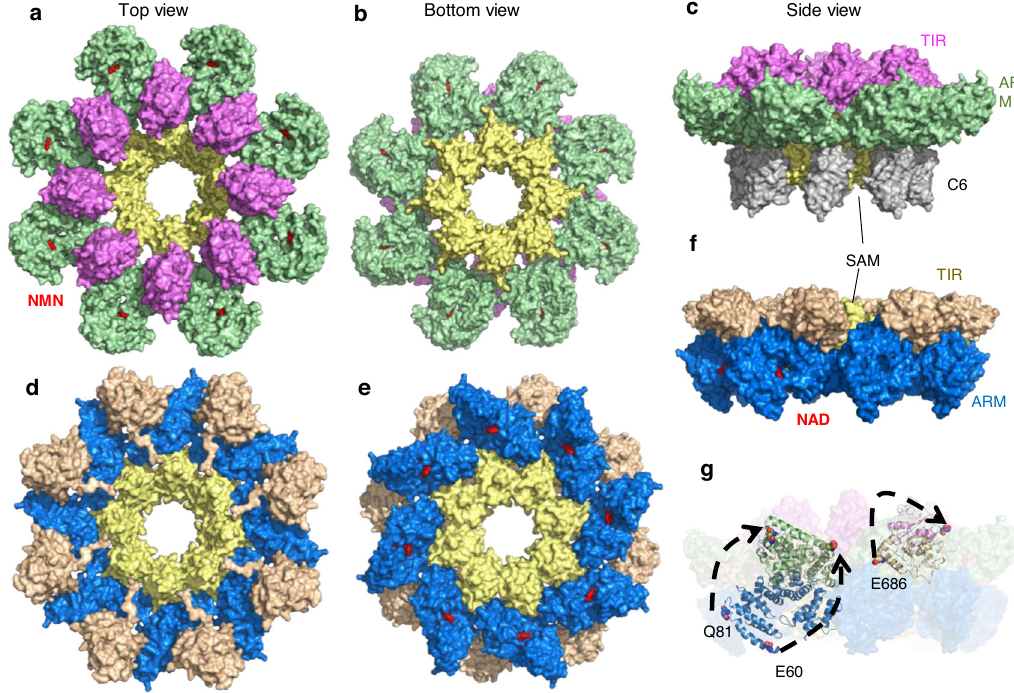
Fig. 3 | Overall structures of active or inactive SARM1. a – c Structure of the SARM1 NMN /Nb-C6complex.TheorderofadditioninformingthecomplexisSARM1 fi rst, NMN second, and then Nb-C6. a top view; b bottom view; c side view. SARM1 and Nb-C6 are shown as surface models with ARM domain colored in green, TIR domain in magenta, SAM domain in yellow and Nb-C6 in grey. NMN is shown as sphere in red. Each Nb-C6 binds one SARM1 protomer. d – f Overall structure of SARM1 NAD (PDB 7ANW). d top view; e bottom view; f side view. SARM1 is shown as surface model with ARM domain colored in blue, TIR domain in wheat and SAM